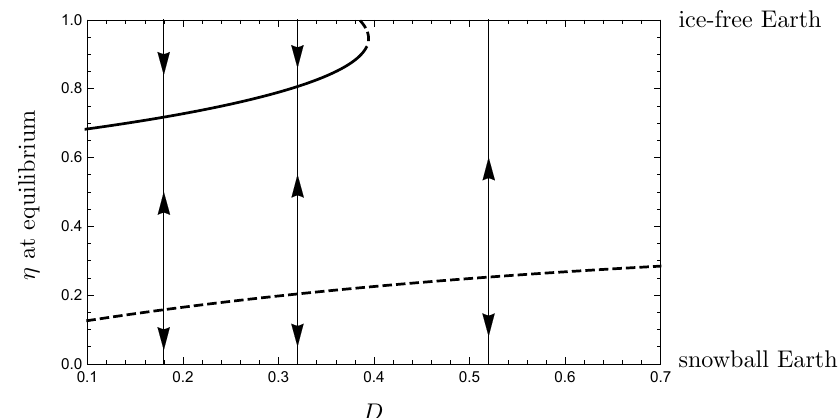
Figure 3. The ice line position at equilibrium as a function of the diffusion coefficient D when N = 1. Solid : Stable equilibria. Dashed : Unstable equilibria.